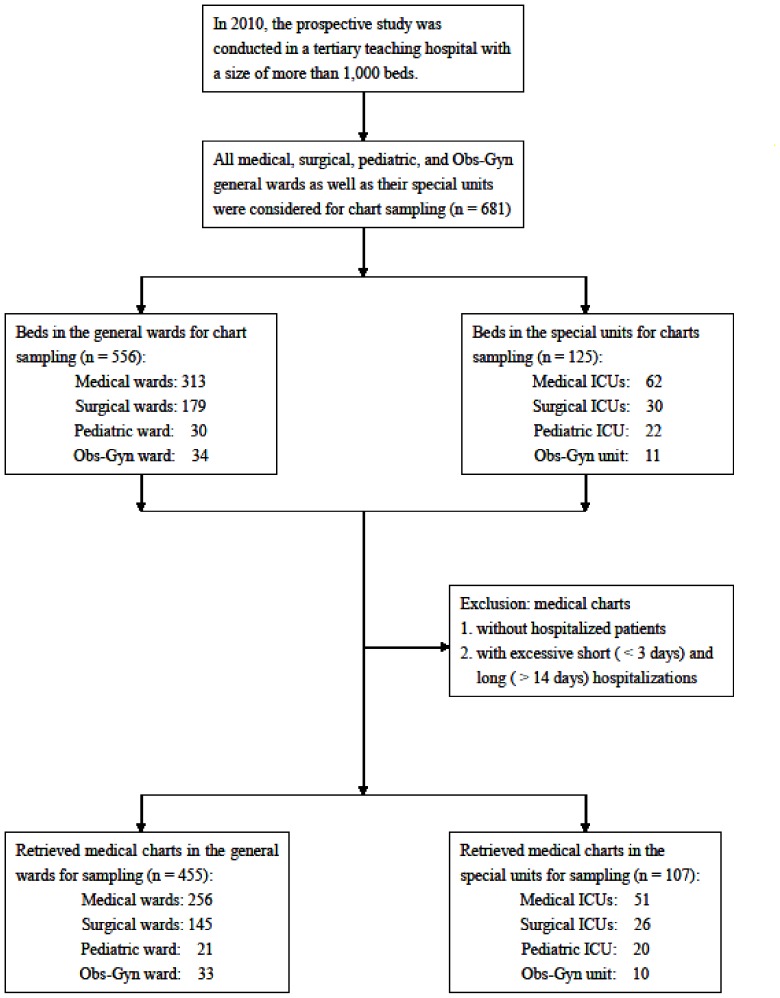
Flow chart for sampling of hospital medical charts.The selection and exclusion of hospital medical charts for sampling to detect possible bacterial contamination.